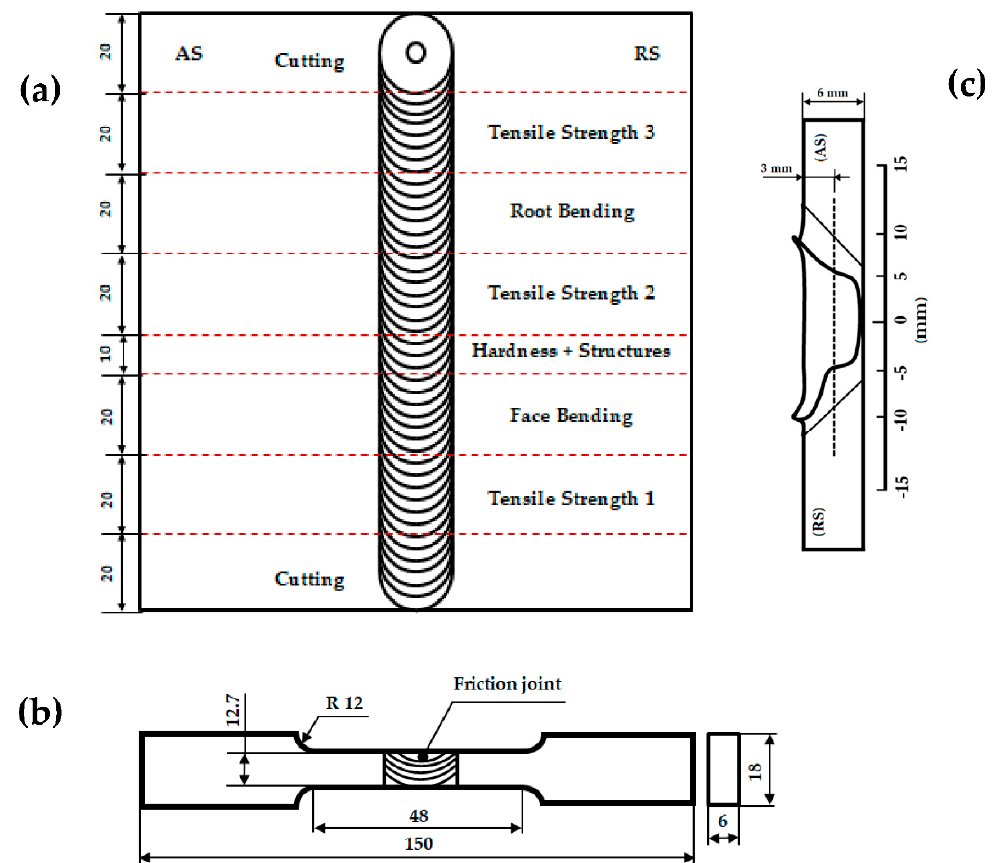
Figure 4. Schematic diagram of FSWp of SSM 6063 aluminum alloys as ( a ) FSW sample, ( b ) tensile strength sample, and ( c ) hardness sample.